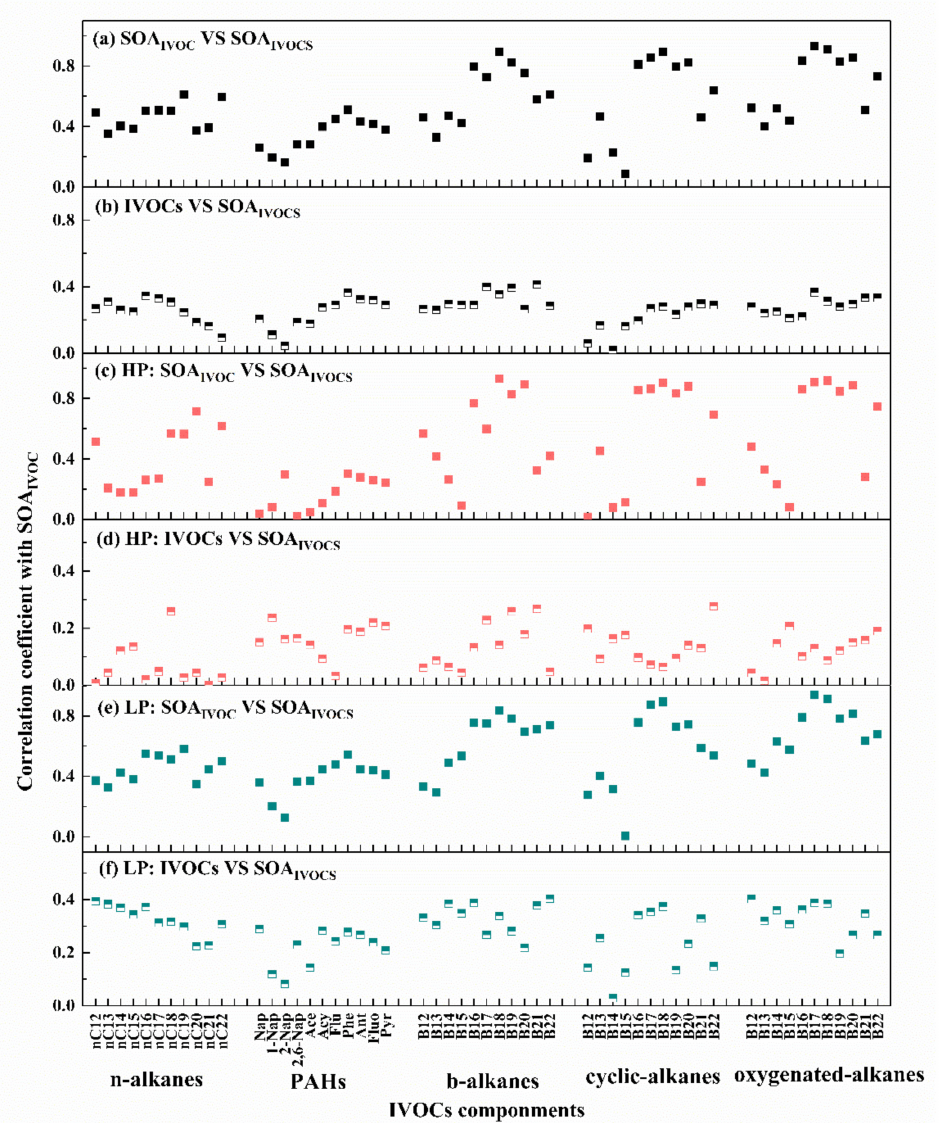
Figure 7. Correlation coefficient (r)of IVOCs components and its corresponding SOA IVOC with SOA IVOCs in haze episodes (black rectangle represents the haze episodes; pink rectangle represents HP stage; green rectangle represents LP stage; SOA IVOC represents the individual IVOC production, SOA IVOCs respesents the total IVOCs production) ( a ): SOA IVOC vs. SOA IVOCs and ( b ): IVOCs vs. SOA IVOCs , HP stages of haze. ( c ): SOA IVOC vs. SOA IVOCs and ( d ): IVOCs vs. SOA IVOCs and LP stages of haze. ( e ): SOA IVOC vs. SOA IVOCs and ( f ): IVOCs vs. SOA IVOCs